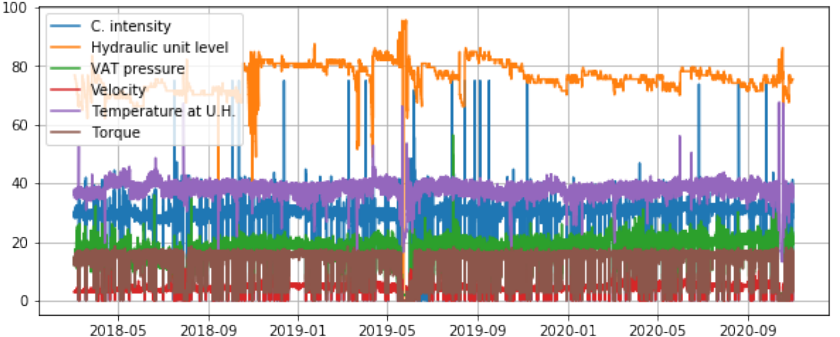
Figure 2. Plot of the original dataset values. The variables are electric current intensity, hydraulic unit oil level, VAT pressure, motor velocity, temperature at the hydraulic unit, and